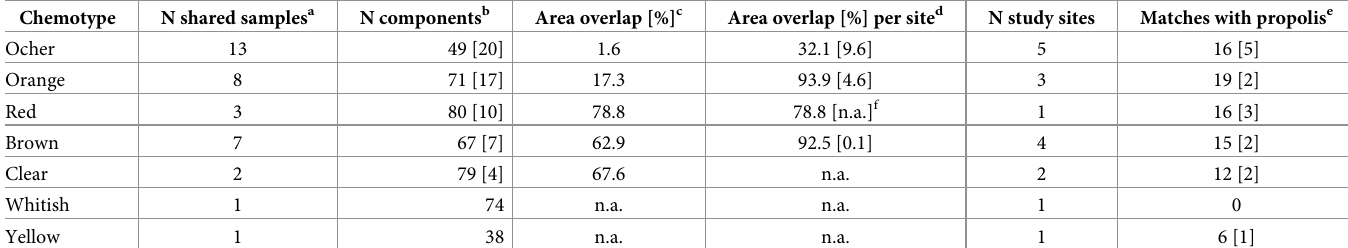
Table 3. Compositional variability among samples of the same resin